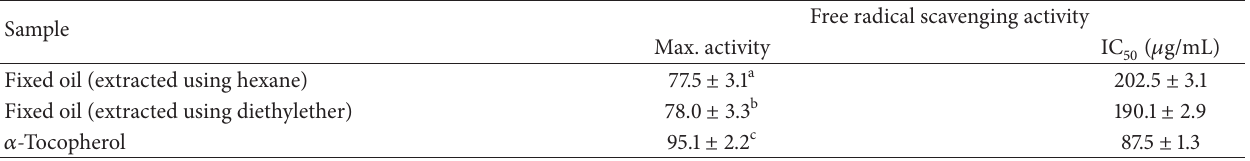
Table 3: Antioxidant activity of the fixed oil.